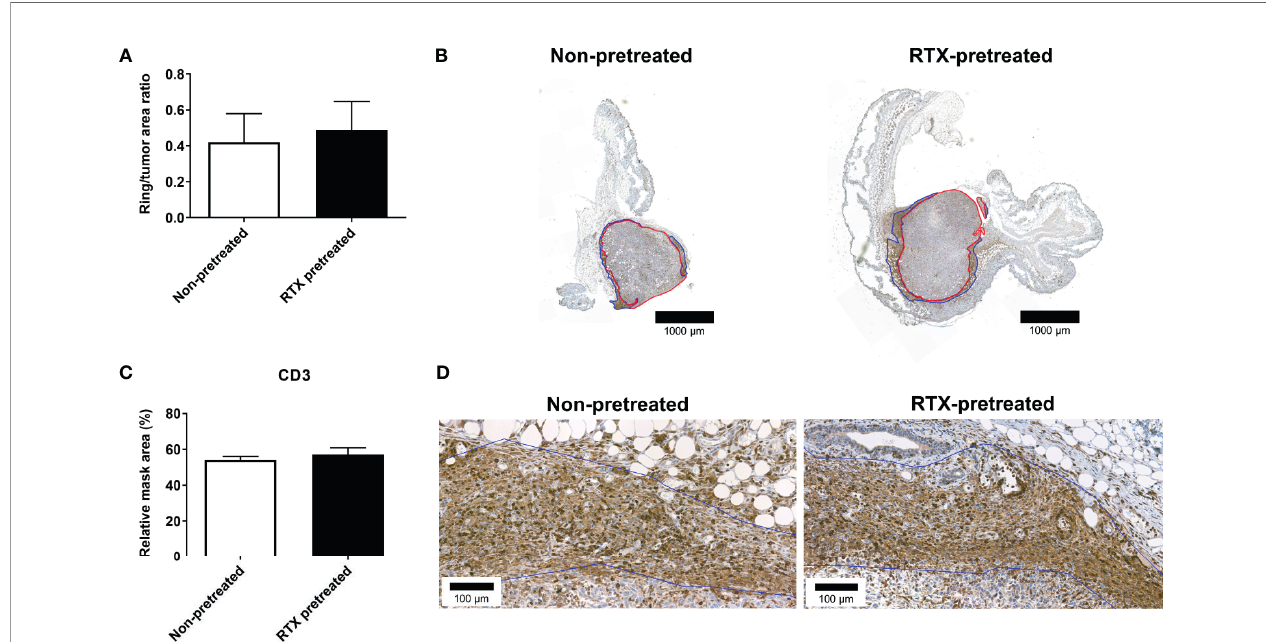
FIGURE 7 | No signi fi cant difference in the CD3 immunoreactivity-based in fl ammatory response in the area surrounding the 4T1 tumors after RTX-pretreatment. (A) Ratio of the in fl ammatory ring area to the entire tumor area (B) Representative anti-CD3 stained sections, demonstrating tumor annotation (red) and the in fl ammatory ring (blue) with low (1.4x) magni fi cation. (C) CD3 expression measured by quantitative immunohistochemistry (relative mask area %). (D) Representative anti-CD3 stained slides with high (23x) magni fi cation. The in fl ammatory ring is marked with blue